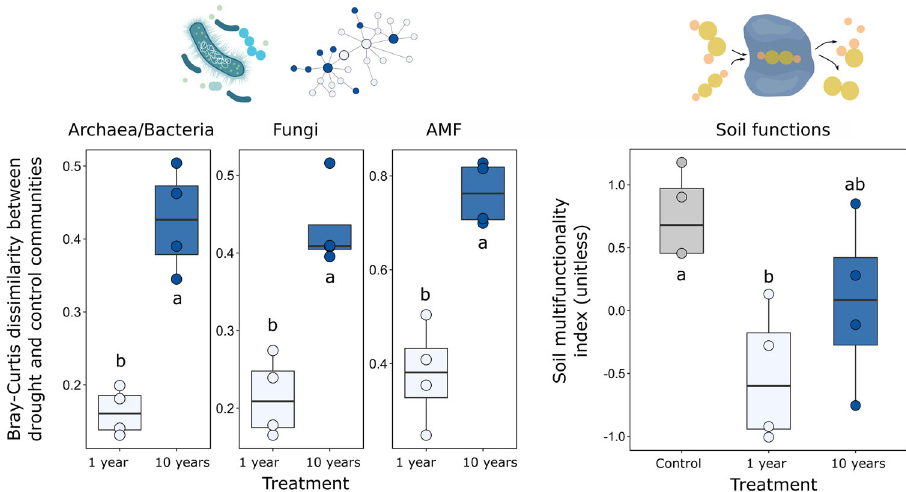
Fig. 6 Effects of drought on microbial community and soil functions. Colour indicates soil treatment (control = grey, 1 year = light blue, 10 years = blue). Left panels show boxplots representing the Bray-Curtis dissimilarity index between drought treatments and control for archaea/bacteria ( F = 44.969, p = 0.0005, n = 4), fungi ( F = 32.86, p = 0.012, n = 4) and AMF ( F = 23.002, p = 0.003, n = 4). The right panel shows boxplots representing the soil multifunctionality index (calculated by a wide set of soil parameters including enzymatic activities, soil C and nutrient stock, microbial biomass C, N and P and root biomass productivity) grouped by treatment ( F = 5.514, p = 0.027, n = 4). Letters represent results from two-sided Tukey HSD post hoc test. Box centre line represents median, box limits the upper and lower quartiles, whiskers the 1.5x interquartile range, while separated points represents